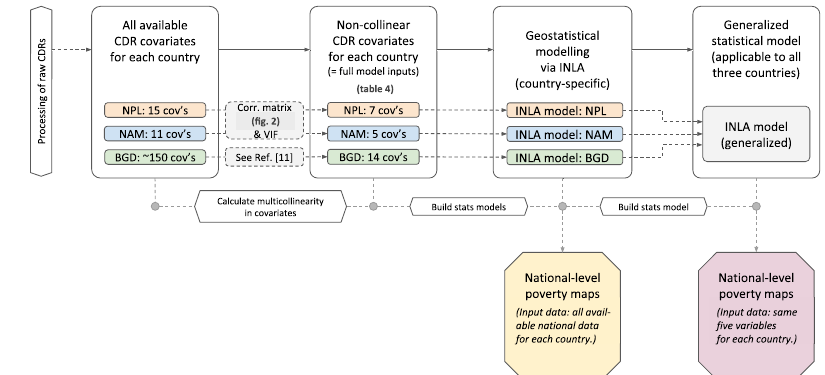
Fig. 3 Data inputs and methodological steps used in this study. This diagram illustrates the processes undertaken to produce national-level poverty maps for each country from raw CDR data.